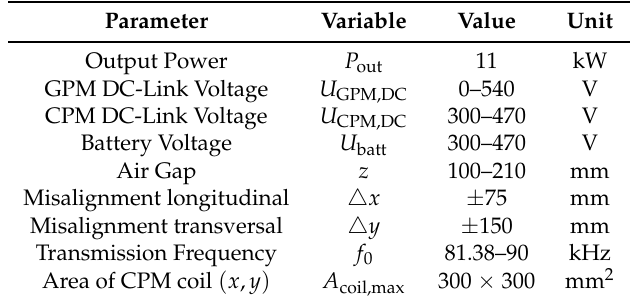
Table 1. System specification and boundary conditions of the exemplary WPTS.